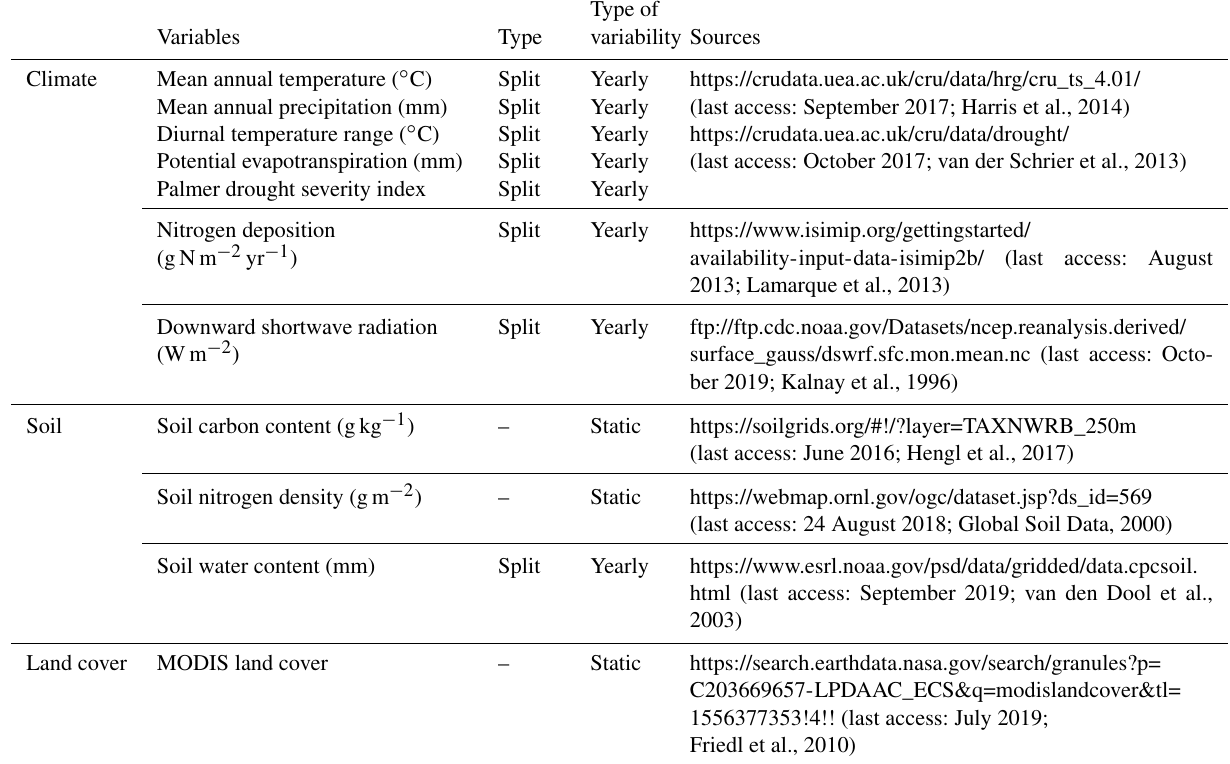
Table 1. Global variables used for producing the global RH